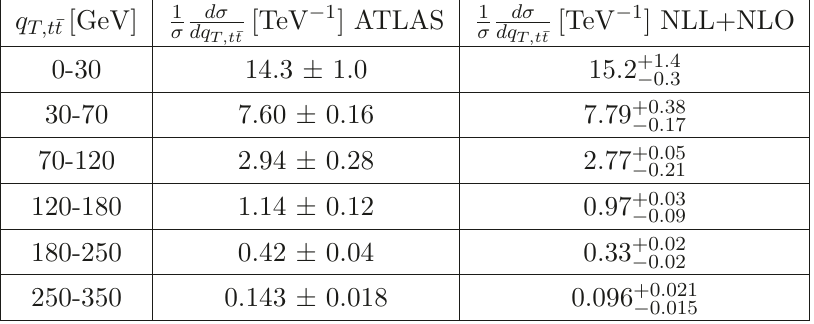
Table 1. The normalized q T distribution 1 /σ ( dσ/dq T ) of t ¯ t pairs in pp collisions at the LHC ( √ s = 8 TeV): comparison between ATLAS data (dilepton channels) [17] and NLL+NLO results.